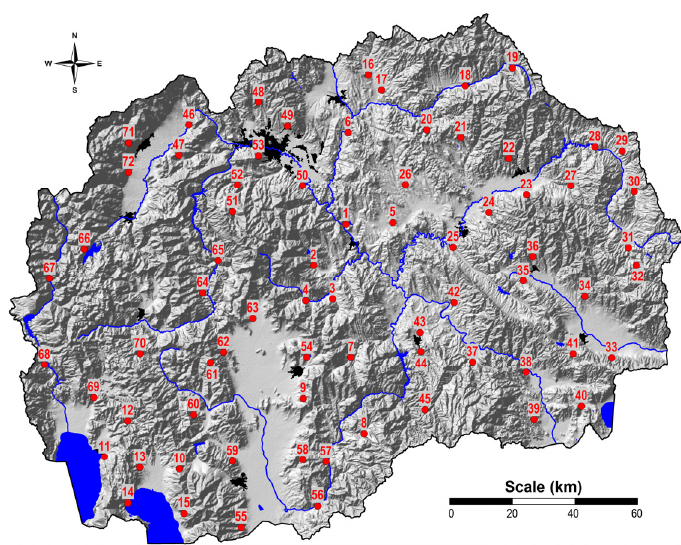
Figure 2. Location of sampling points.